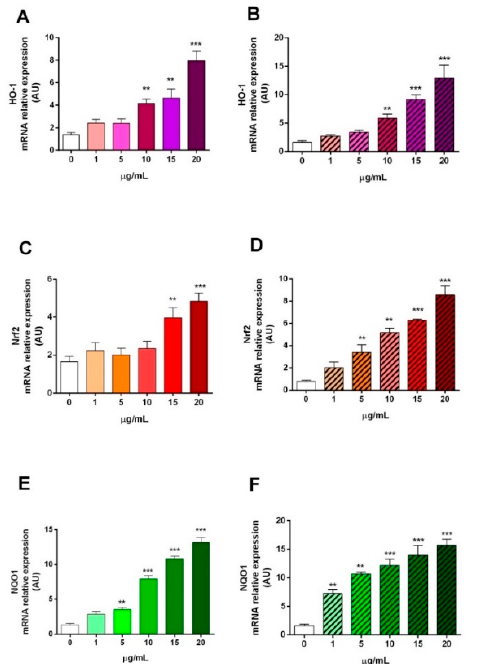
Figure 7. mRNA expression in Caco ‐ 2 cells of heme oxygenase ‐ 1 (HO ‐ 1) ( A and B ), nuclear factor (erythroid ‐ derived 2) ‐ like 2 (Nrf2) ( C and D ), and NAD(P)H quinone reductase (NQO1) ( E and F ) after treatment with flower extracts of Artocarpus heterophyllus Lam. (left) and Artocarpus lakoocha Roxb. (right), 0–20 μ g/mL. Data are expressed as fold changes of the target gene (Nrf2 in A , HO ‐ 1 in B , and NQO1 in C ) normalized to the internal standard control gene ( β‐ actin). All measurements were performed in triplicate. Data are shown as the mean ± standard deviation, and one ‐ way ANOVA with a Newman–Keuls post ‐ test was used for statistical significance; * p < 0.05; ** p < 0.005; *** p < 0.0001 vs. 0 μ g/mL.